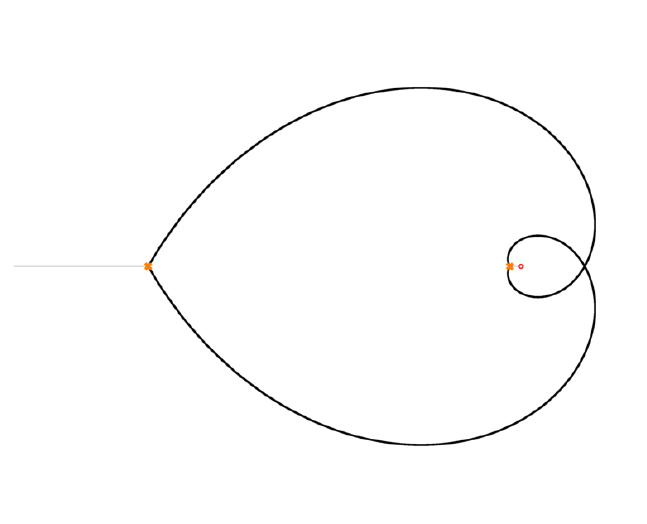
Figure 26. Spectral network at Q = (cid:0) 1, on the line of marginal stability.